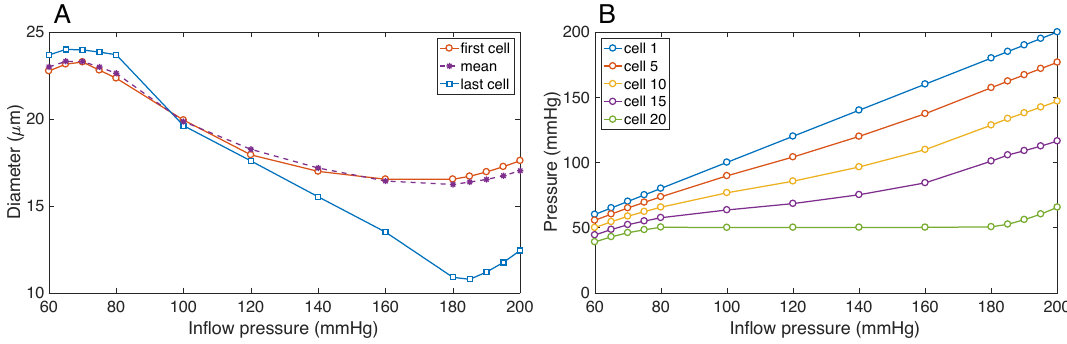
Figure 6. ( A ) Predicted steady-state diameter (calculated by time-averaging for the first and last cells and calculated by space- and time-averaging for the mean) across the afferent arteriole cells for a range of time independent blood pressures; ( B ) Predicted myogenic response of blood flow for five cells in the afferent arteriole for a range of blood